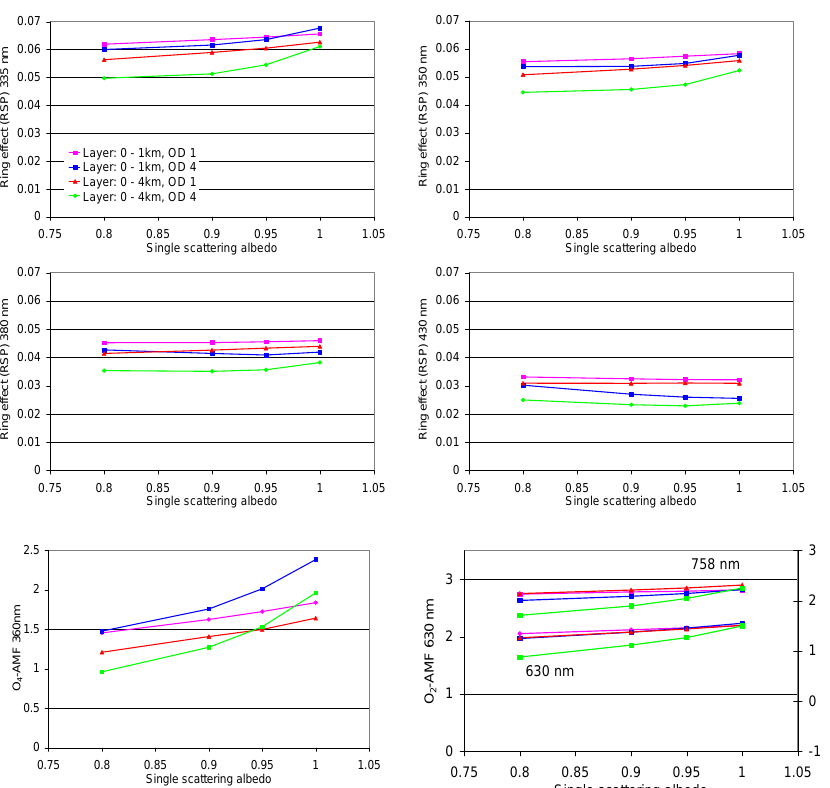
Fig. 17 Dependence of the Ring effect and the O 2 and O 4 absorptions on the aerosol single scattering albedo. The calculations are performed for SZA of 30° and a viewing angle of -90° (nadir geometry). The aerosol asymmetry parameter was assumed to be 0.68. For 758nm the surface albedo was set to 20%, for 630nm to 10%, and for all other wavelengths to 5%. large wavelengths the dependence on AOD is more pro-